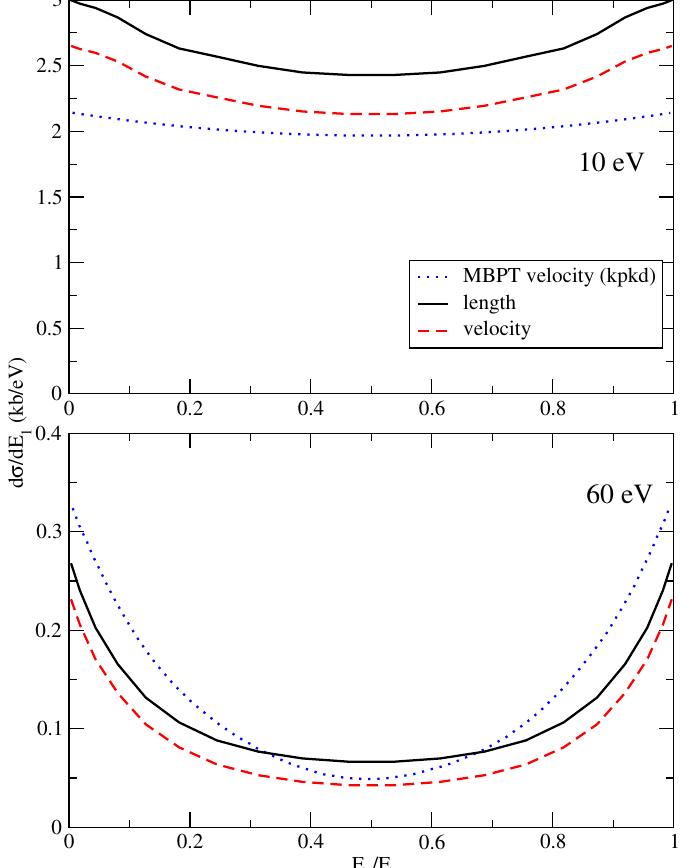
Figure 2. Single-differential cross-section (SDCS) results from DPI of 3 P carbon at two excess energies: 10 eV ( upper panel) and 60 eV ( lower panel). Present results in the length (solid black line) and velocity (dashed red line) gauges are compared with the kpkd contribution of MBPT (dotted blue line) from Ref. [22]. 1 kb = 10 − 21 cm 2